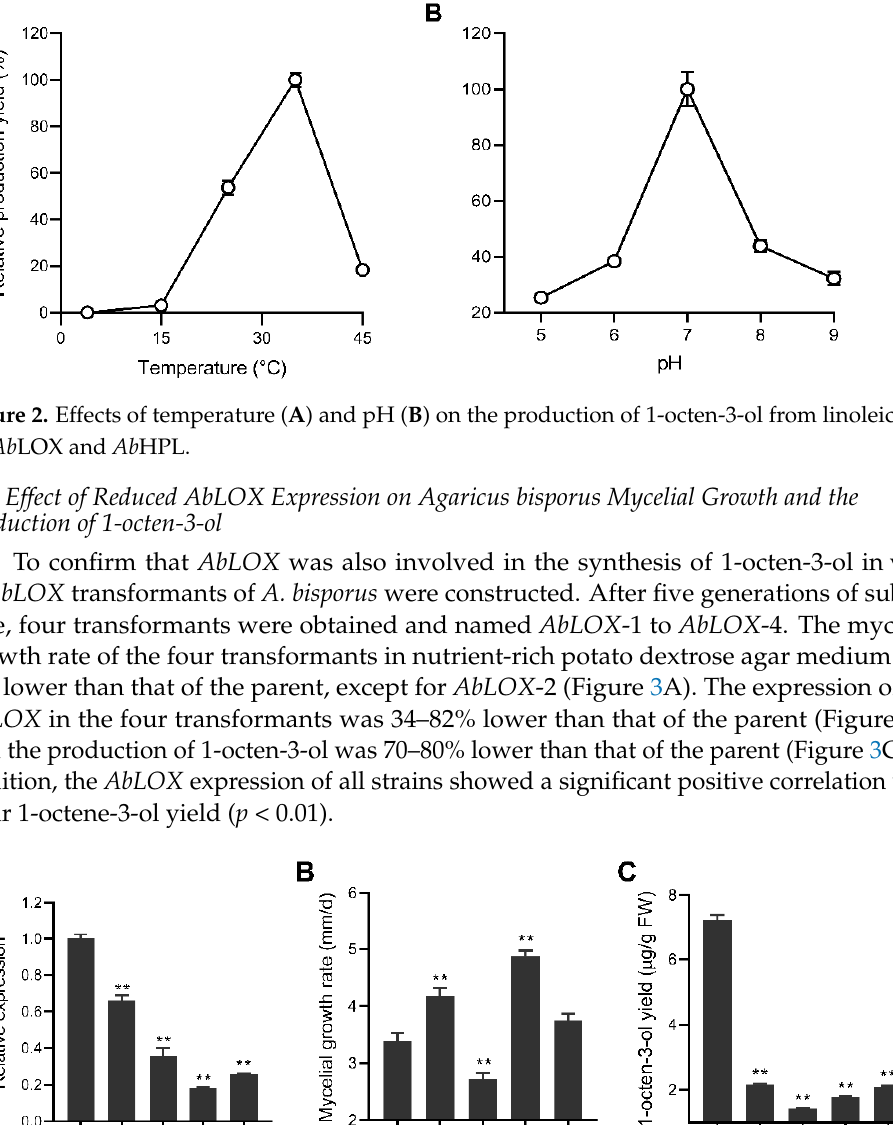
Figure 1. GC-MC analysis chromatogram of 1-octen-3-ol production in the enzymatic linoleic acid reaction. ( A ) Authentic sample of 1-octen-3-ol. ( B ) Enzymatic reaction by Ab LOX. ( C ) Enzymatic reaction by Ab LOX + Ab HPL. ( D ) Enzymatic reaction by Ab LDS1 + Ab HPL. ( E ) Enzymatic reaction by Ab LDS2 + Ab HPL.